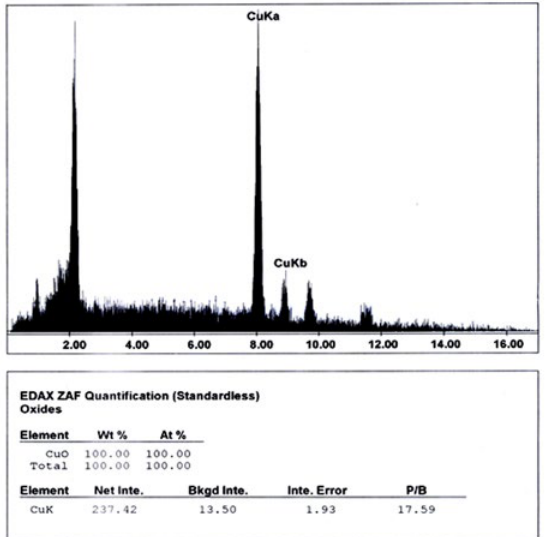
Fig. 6. EDX spectrum of as-synthesized products by calcination of the [Cu(BDC)(bipy)](BDCH